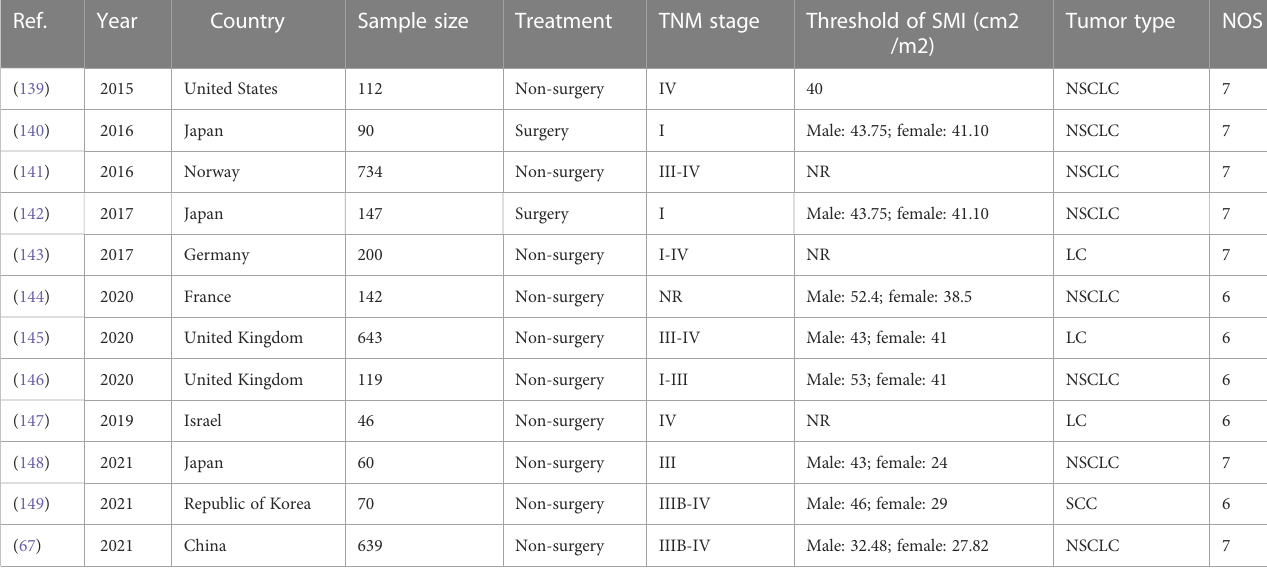
TABLE 2 The primary characteristics and clinical features of included studies.